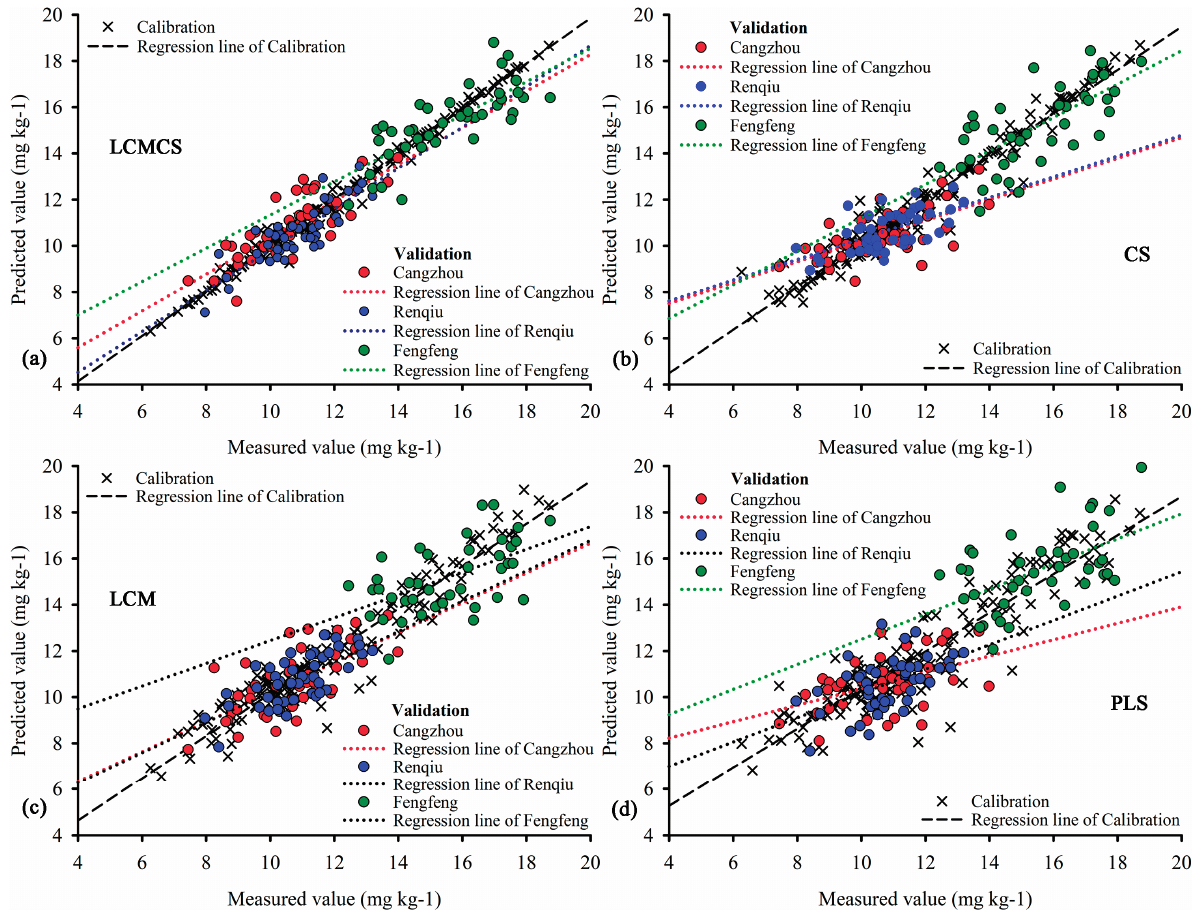
Figure 9. Comparisons of measured and predicted values by the local correlation maximization-complementary superiority method (LCMCS) ( a ); complementary superiority (CS) ( b ); local correlation maximization (LCM) ( c ) and partial least squares regression (PLS) ( d )